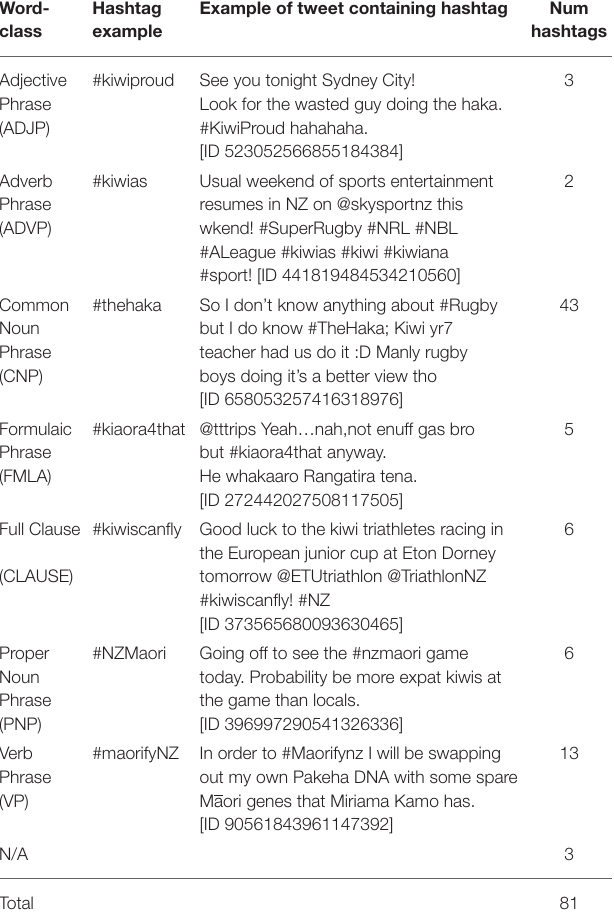
TABLE 4 | Word-classes of the various hybrid hashtags in the HH sub-corpus. Word- class